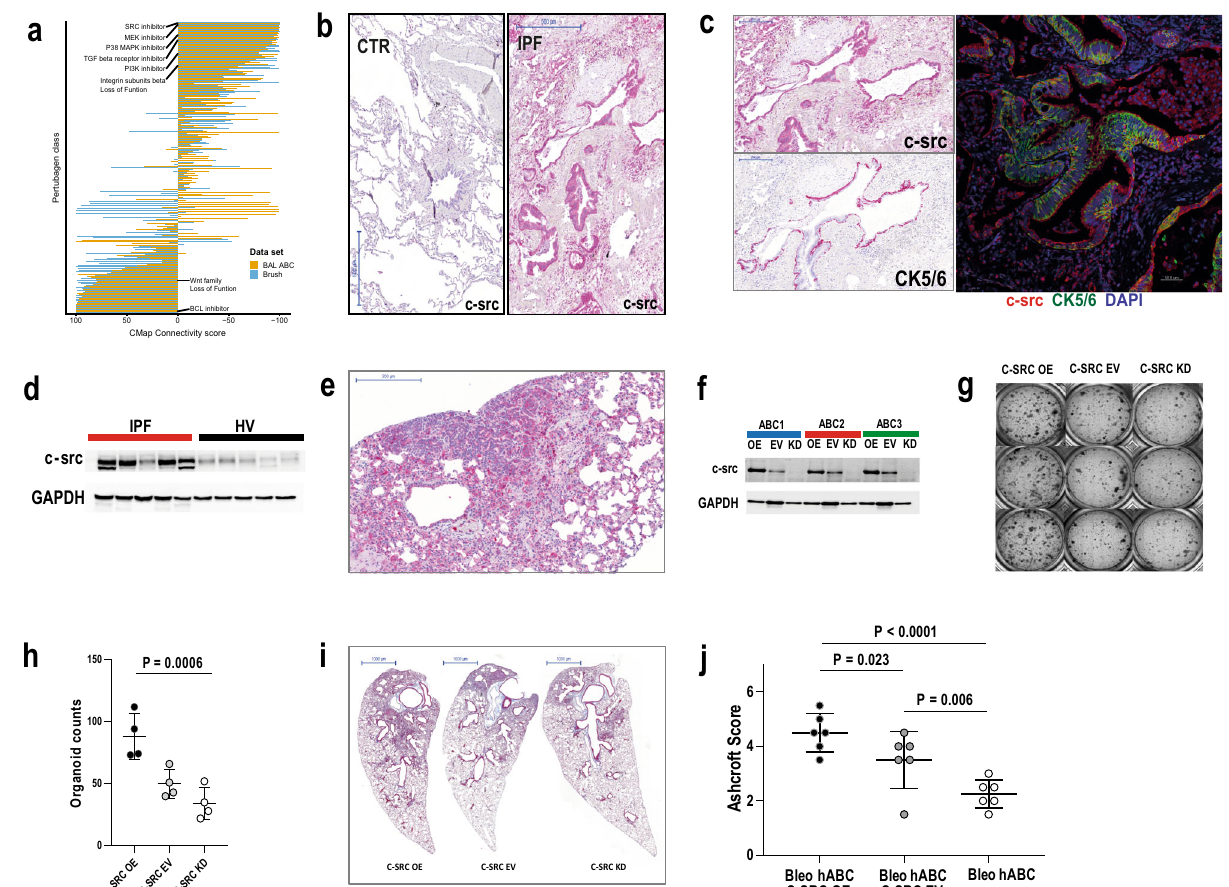
Fig.4|CMapofscRNAseqdataidenti fi espotentialtreatmentstrategiessuchas src inhibition. Overexpression of c-src in IPF lungs and cellular effects of c-src overexpressionandknockdown. a BarplotsofsummaryCMapConnectivityscores of the clue.io analysis, dodged by input (ABC mortality signature — yellow, scSeq- derived DEGs IPF vs nonUIP ILD control in ABCs — blue). Inhibition of SRC had the lowest CMap Connectivity score, i.e., potentially reversing the input gene sig- natures. b , c In normalhumanlungtissue ( n =5)c-srcexpression waslow,only few macrophageswerestainedpositively.Incontrastc-srcexpressionofIPFlungtissue ( n =10) was high. b Macrophages and epithelial cells highly expressed c-srcaswell as lymphocytes within lymphoid follicles. c Most of the epithelial cells expressing c-srcwerealsopositiveforCK5/6identifyingthemasbasalcells. d c-srcexpression was high in lung tissue homogenates of IPF patients compared to healthy donors. e Immunohistochemistry of murine lungs ( n =10) of the described humanized